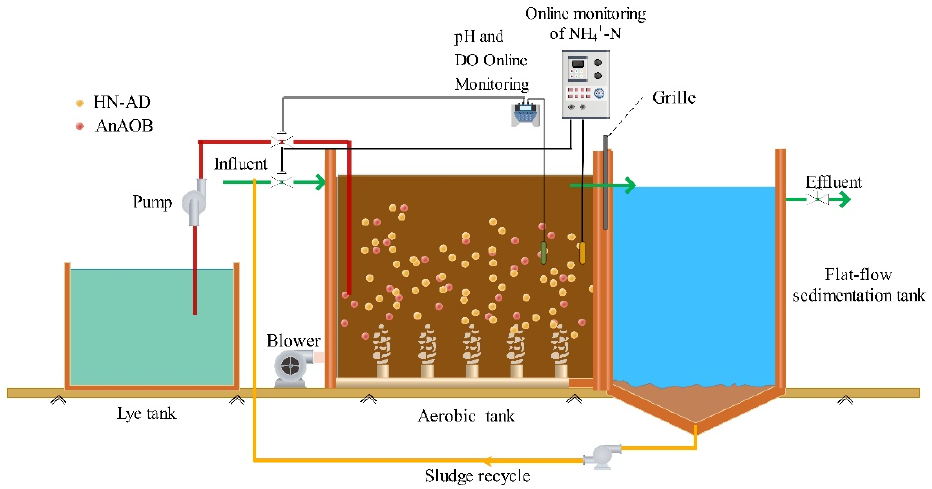
Figure 1. One-stage SNDA process flow diagram.